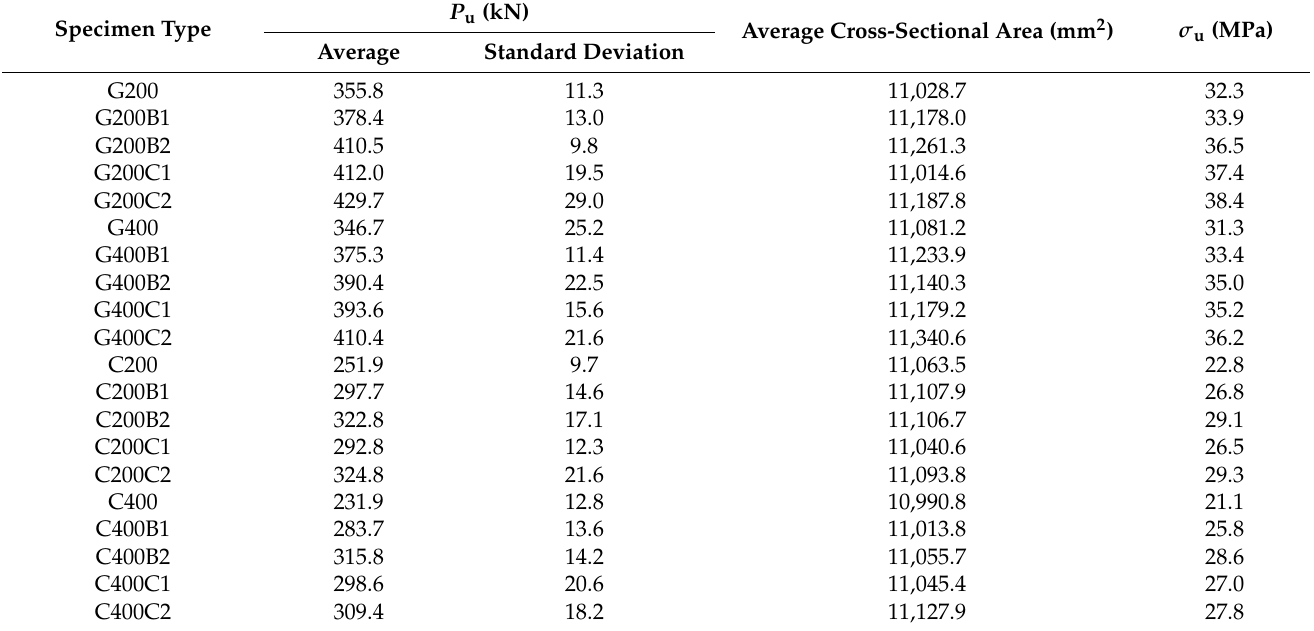
Table 3. Average ultimate load tested in the monotonic